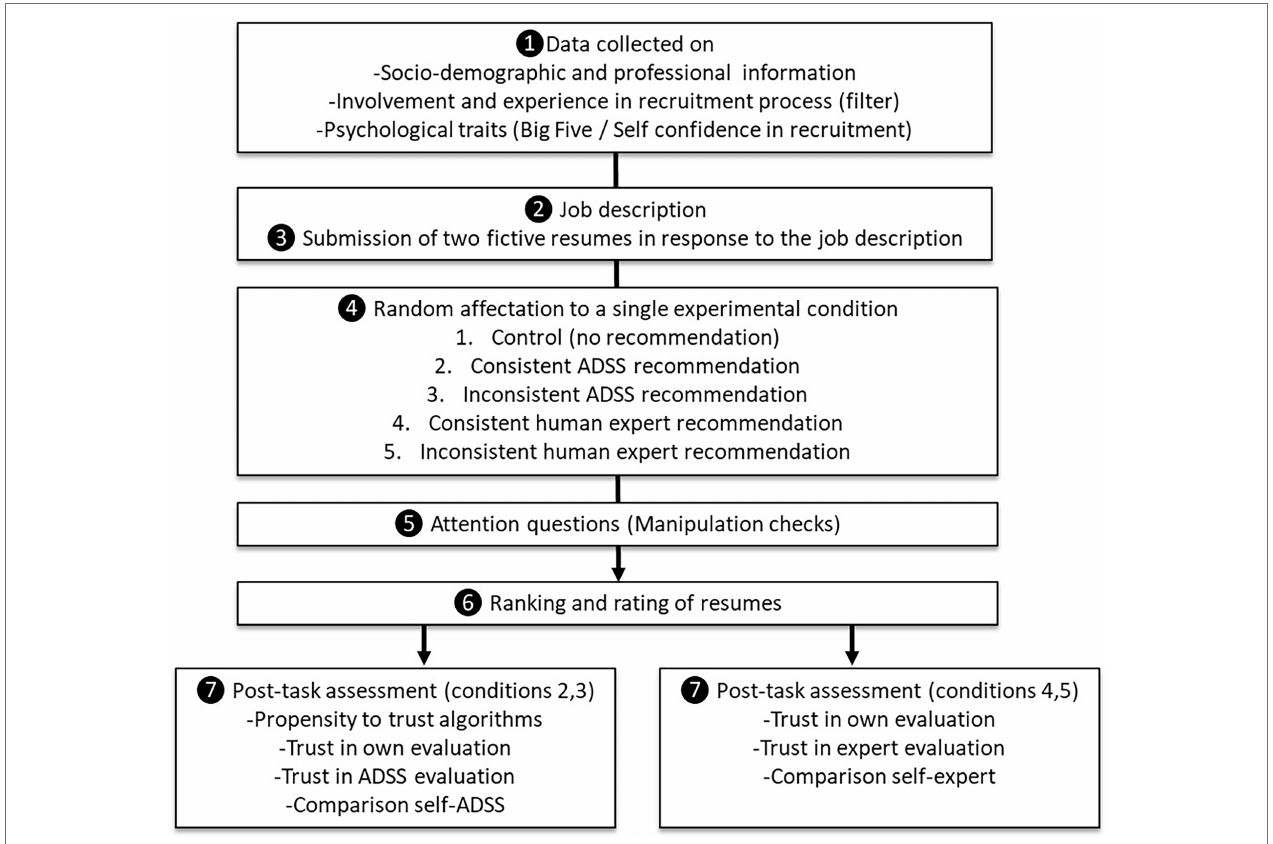
FIGURE 2 | Overview of experimental